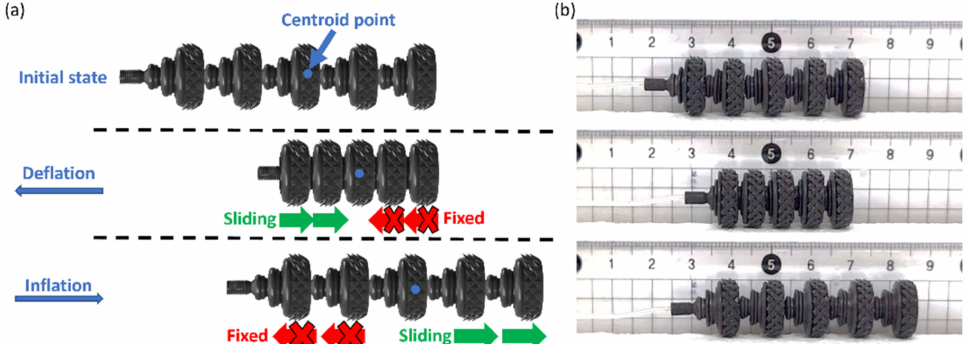
Figure 3. Locomotion model of MSSR. ( a ) Movement mechanism of MSSR with five modular soft actuator units connected. ( b ) Images of the moving MSSR during one